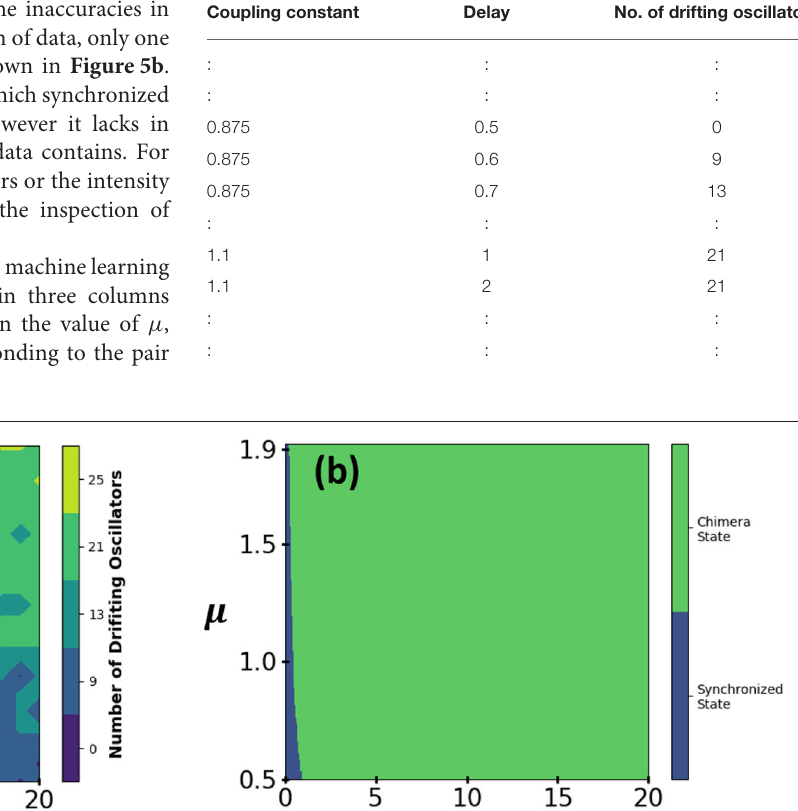
TABLE 1 | Data structure for Rippling data: there are 800 rows in total in this table. Coupling constant